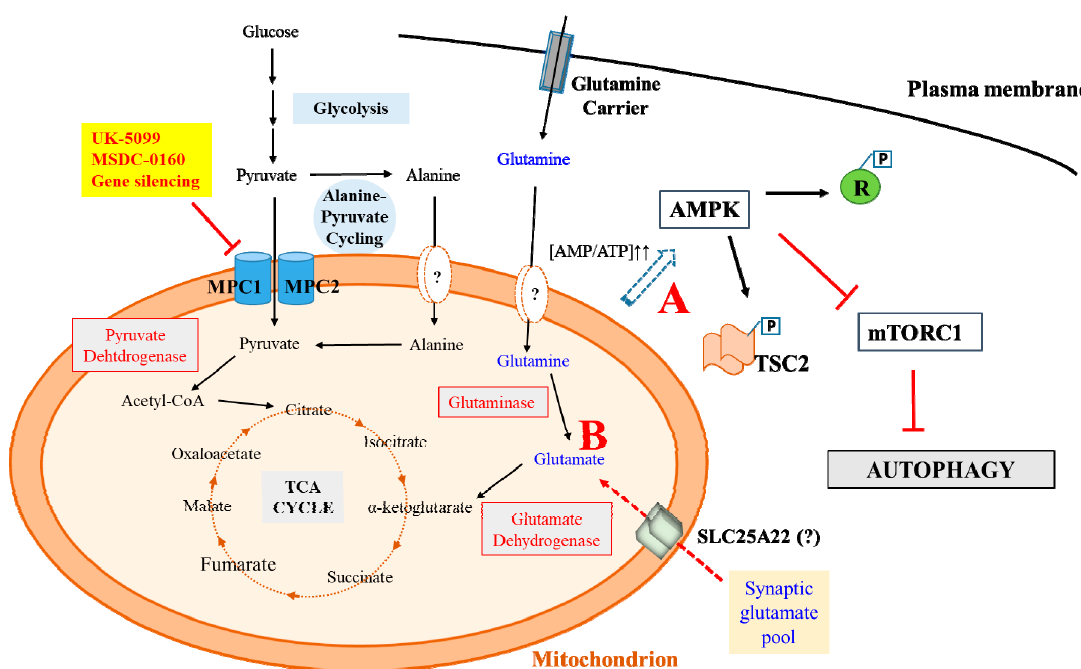
Figure 1. A schematic diagram summarizing the pathways and possible mechanisms underlying mitochondrial pyruvate carrier (MPC) inhibition-mediated neuroprotection that has recently came to light. Metabolic adaptations in a neuronal cell that underlie neuroprotection could result in an Inhibition of mechanistic target of rapamycin complex 1 (mTORC1) via AMP-dependent protein kinase (AMPK) activation due to increased AMP / ATP ratio ( A ), which promotes neuroprotective autophagy. AMPK could inhibit mTORC1 by phosphorylating Raptor (R) or Tuberous sclerosis complex 2 (TSC2). Metabolic adaptations could also promote a switch to oxidizing alternative substrates like glutamate ( B ), which may reduce the synaptic glutamate pool, thus attenuating excitoxicity. Glutamate feeding into tricarboxylic acid (TCA) cycle (conversion of glutamate to α -ketoglutarate by glutamate dehydrogenase sustains the anaplerotic needs of the cell. Reduced mitochondrial pyruvate import and feeding into the TCA cycle may conceivably also be compensated by enhanced alanine-pyruvate cycling.